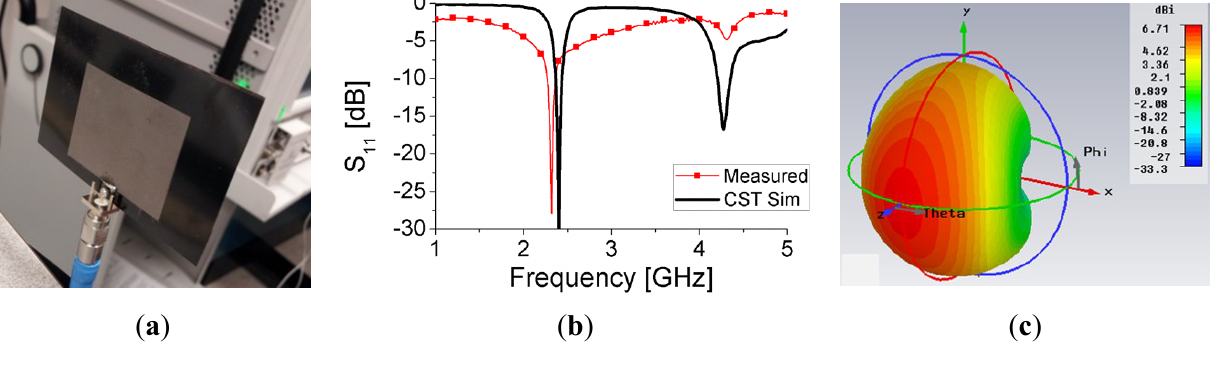
Figure 6. ( a ) Graphite Patch Antenna; ( b ) Measured and simulated response; ( c ) Simulated radiation pattern (adapted from [17], Copyright 2013, permission granted by Kristen Parrish).